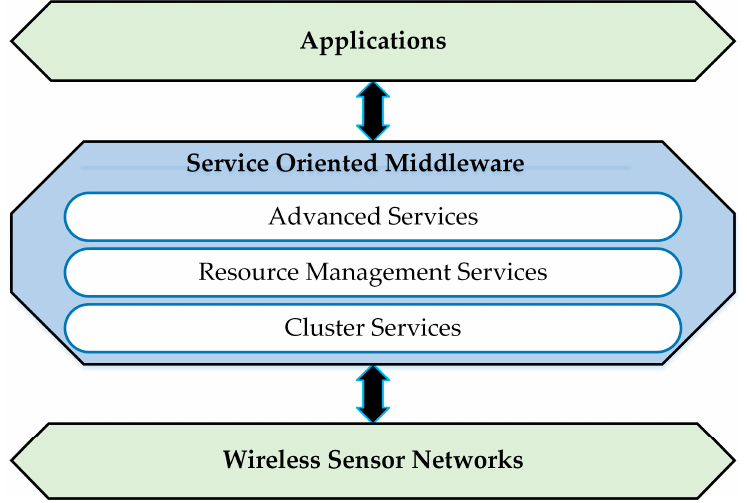
Figure 2. The SOM Architecture Layers for WSNs [4].